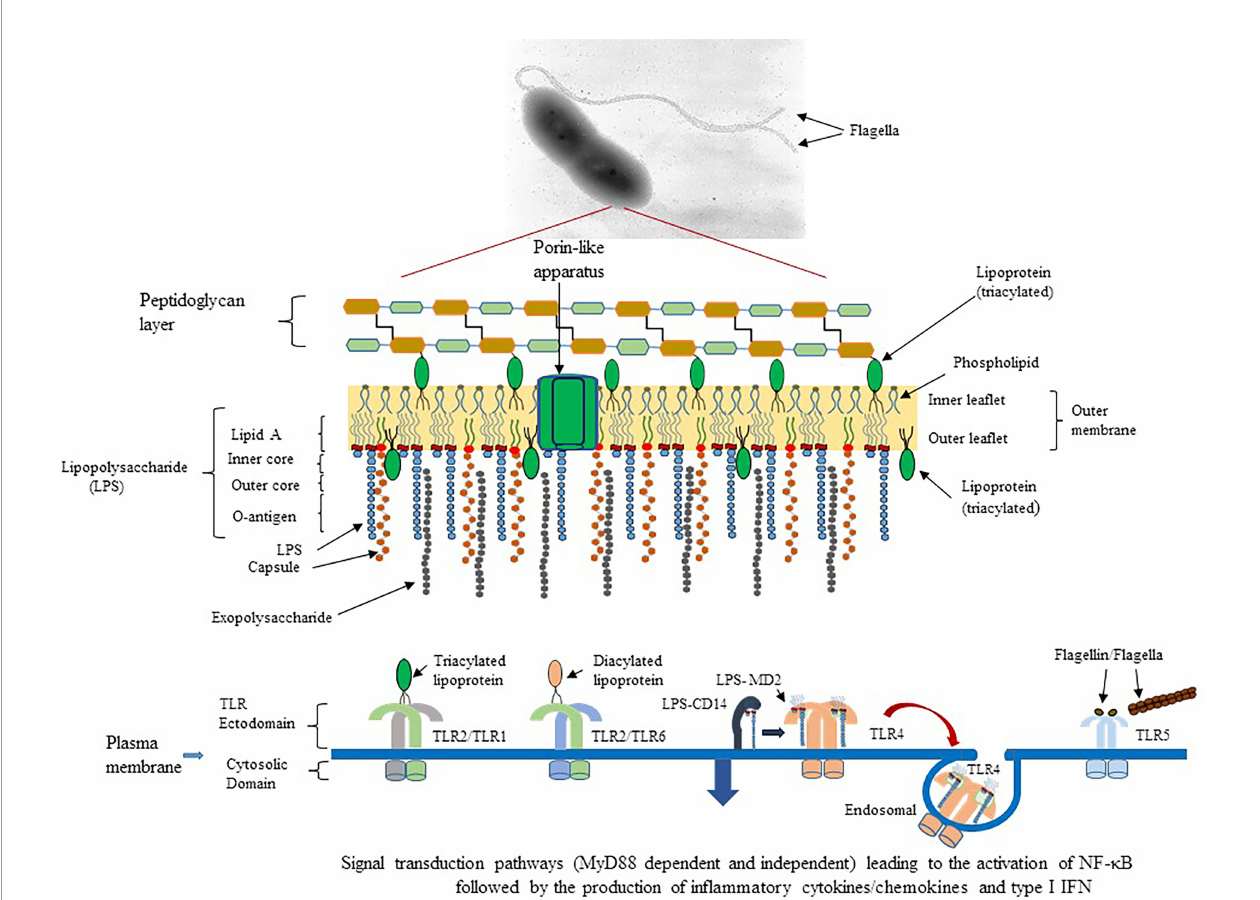
FIGURE 1 | Schematic diagram of potential outer membrane components of Gram-negative pathogens that could interact with surface expressed TLR of the host ’ s innate immune system. An example of B. pseudomallei 1026b, a motile, human pathogen that causes melioidosis, and the presence of pathogen associated molecular patterns (PAMPs) or molecules that can activate TLR of the host is presented (Kawai and Akira, 2010). TLR2/TLR1 (heterodimer) could be activated by triacylated lipoproteins that are embedded in the inner and outer lea fl et of the bacterial membrane. TLR2/TLR6 (heterodimer) can be activated by diacylated lipoproteins that are usually found in Gram-positive bacteria. TLR4 (homodimer) is activated by lipid A which is part of the LPS moiety found in the outer membrane of Gram-negative bacteria. LPS molecules are recognized by CD14 and transferred to the MD2-TLR4 complex before activation of TLR4. A subset of the LPS-MD- TLR4 complex is brought into the host cell by endocytosis, which is facilitated by CD14. TLR5 (homodimer) is activated by the fl agellin molecule, which is the subunit of fl agella. Activation requires at least one fl agellin molecule per TLR5 molecule for optimal activation of the homodimer. In addition, TLR5 can be activated by fl agella, which we show in the current report. All surfaced expressed TLRs transmit their activation signal across the host membrane into the cytoplasm and recruit the signal transduction protein MyD88 and TIRAP to transmit the signal leading to activation of NF- k B and expression of AP-1 to stimulate proin fl ammatory cytokine/ chemokine production. However, the endosomal LPS-MD2-TLR4 complex recruits TRIF and TRAM to transmit the signal for TLR4 activation, which leads to the activation of NF- k B and induction of proin fl ammatory cytokines/chemokines and antimicrobial type I